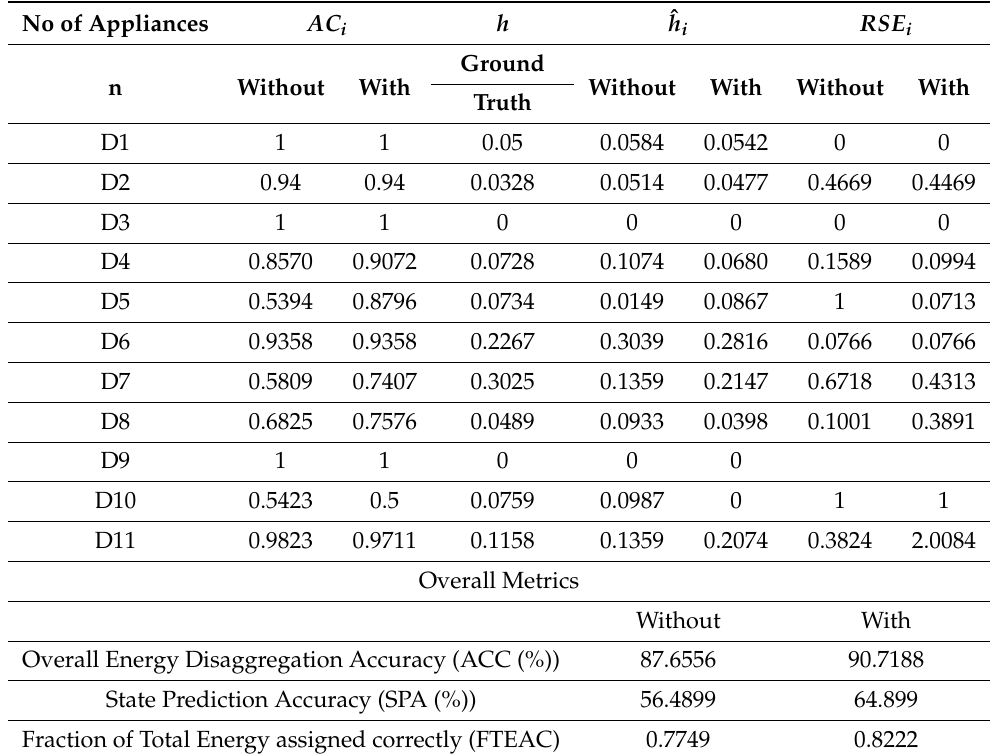
Table 2. Effect of appliance-specific constraints on the performance of energy disaggregation consid- ering the I 1 problem instance.